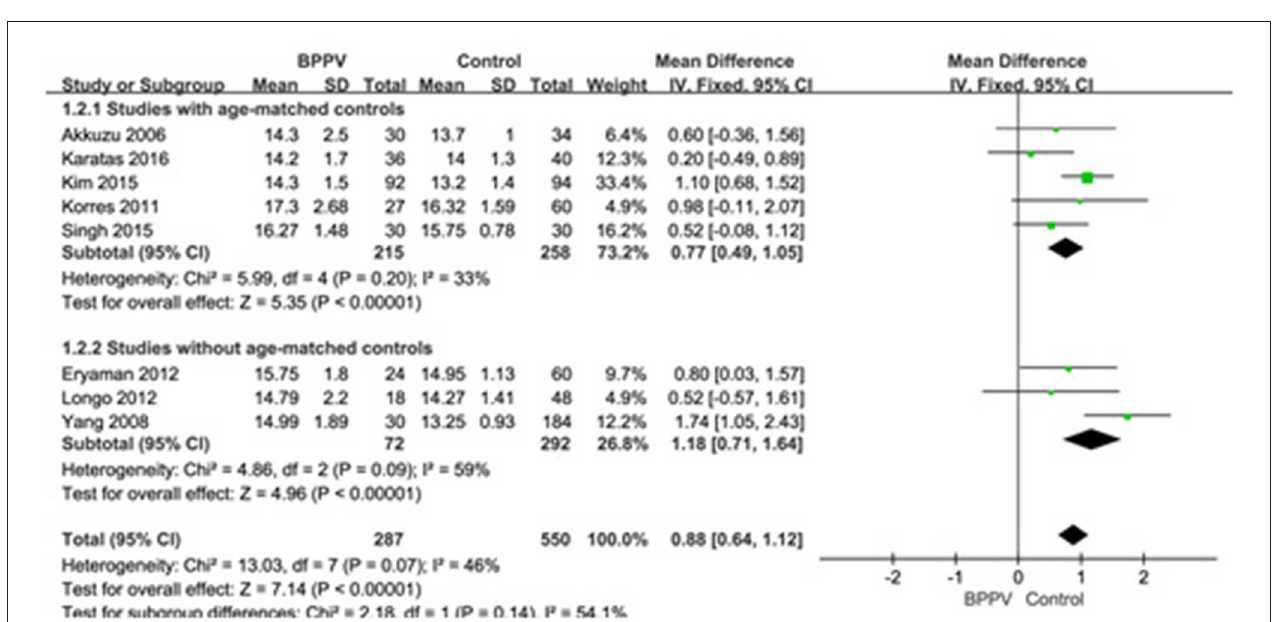
FIGURE 2 | Forest plots of subgroup meta-analysis of p13 latency of cVEMP based on whether or not the age matches between BPPV and healthy groups. BPPV, benign paroxysmal positional vertigo; cVEMP, cervical vestibular evoked myogenic potential.